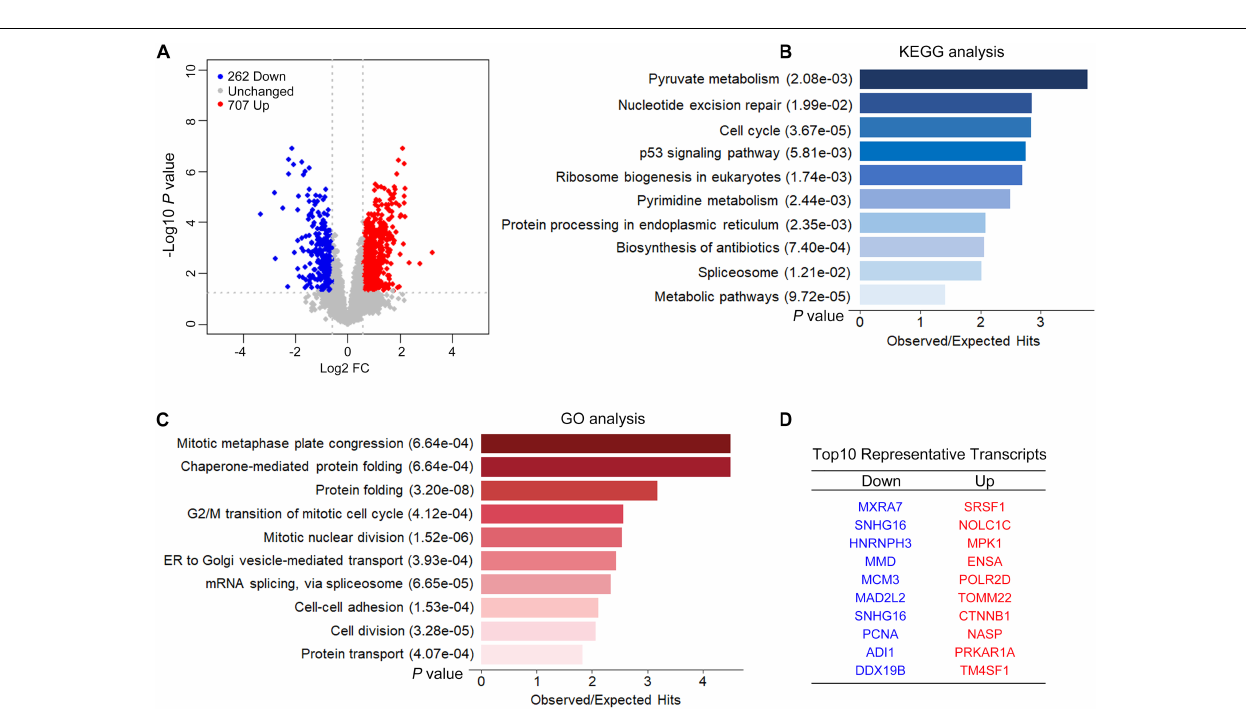
FIGURE 4 | Transwell migration and invasion assays. (A) Transwell migration, and (B) invasion assays were conducted in the CPSF1 knockdown or CPSF1 overexpression groups to determine the effect of CPSF1 on cell invasion and analyzed using Student’s t -test. Statistical data are presented as the mean ± SD. * P < 0.05 and ** P < 0.01.